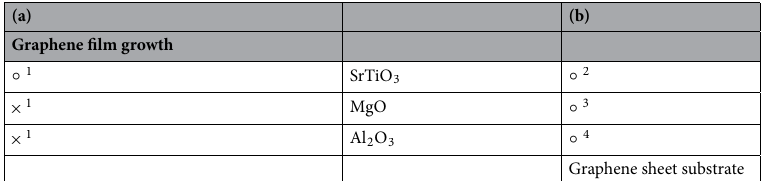
Table 3. The summary of graphene growth on SrTiO 3 , MgO and Al 2 O 3 substrates and vice versa. (a) graphene film grown on the substrates, and (b) each materials grown on graphene sheet. 3 4 Reference 30 . Reference 31 . Reference 33